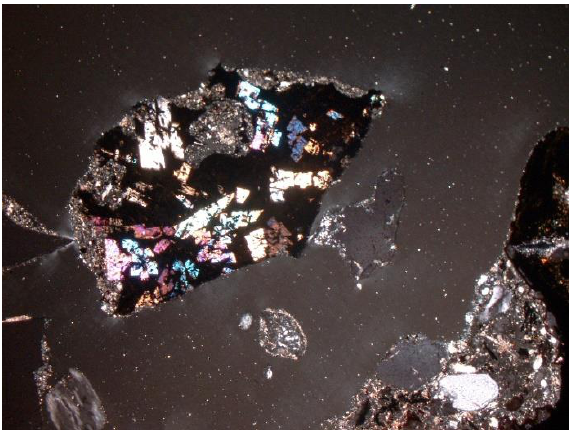
Figure 24. Metallic substance. Unburned fragment of anthropogenic origin. SP2 sample, thin section, 2P, 100×, transmitted light.